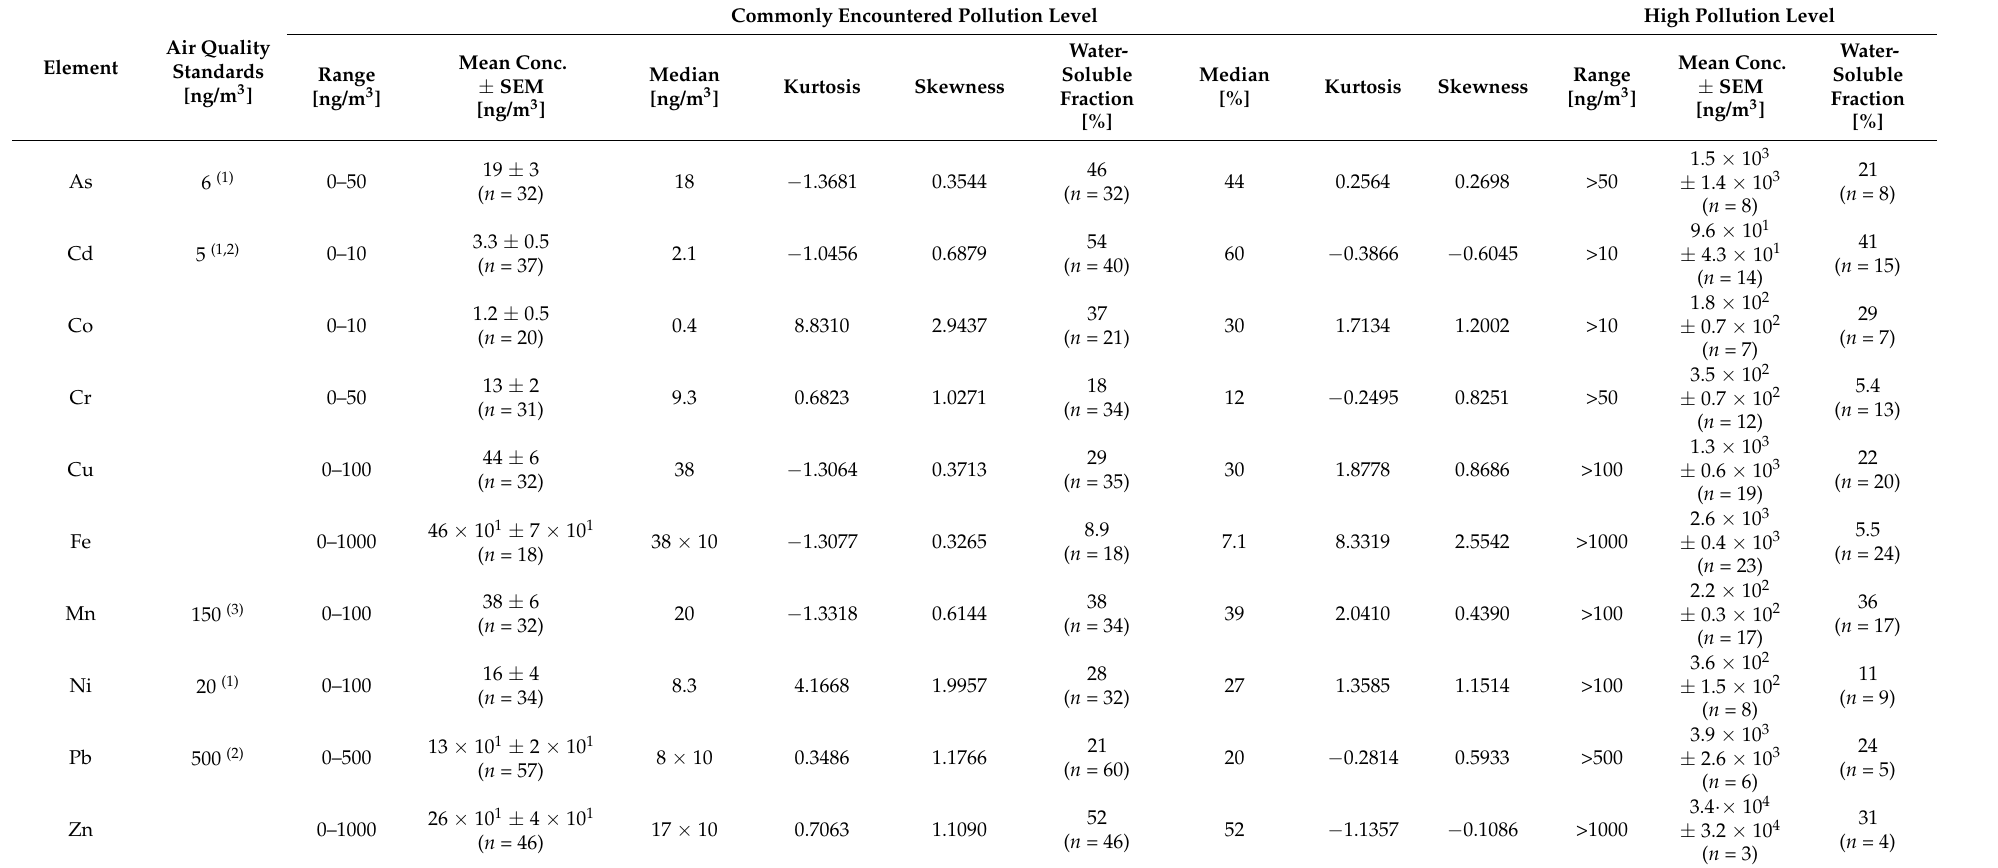
Table 5. The mean concentrations and the percentage of the water-soluble fraction of the ten PTEs in the air in urban areas around the